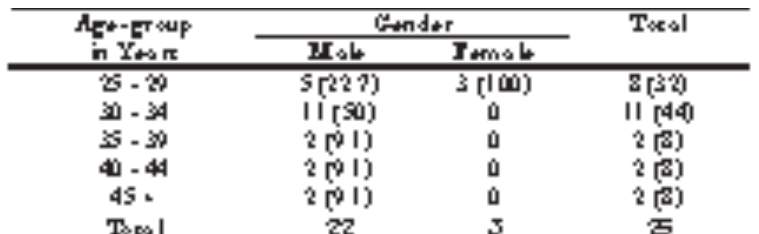
Table I : Age - Gender distribution